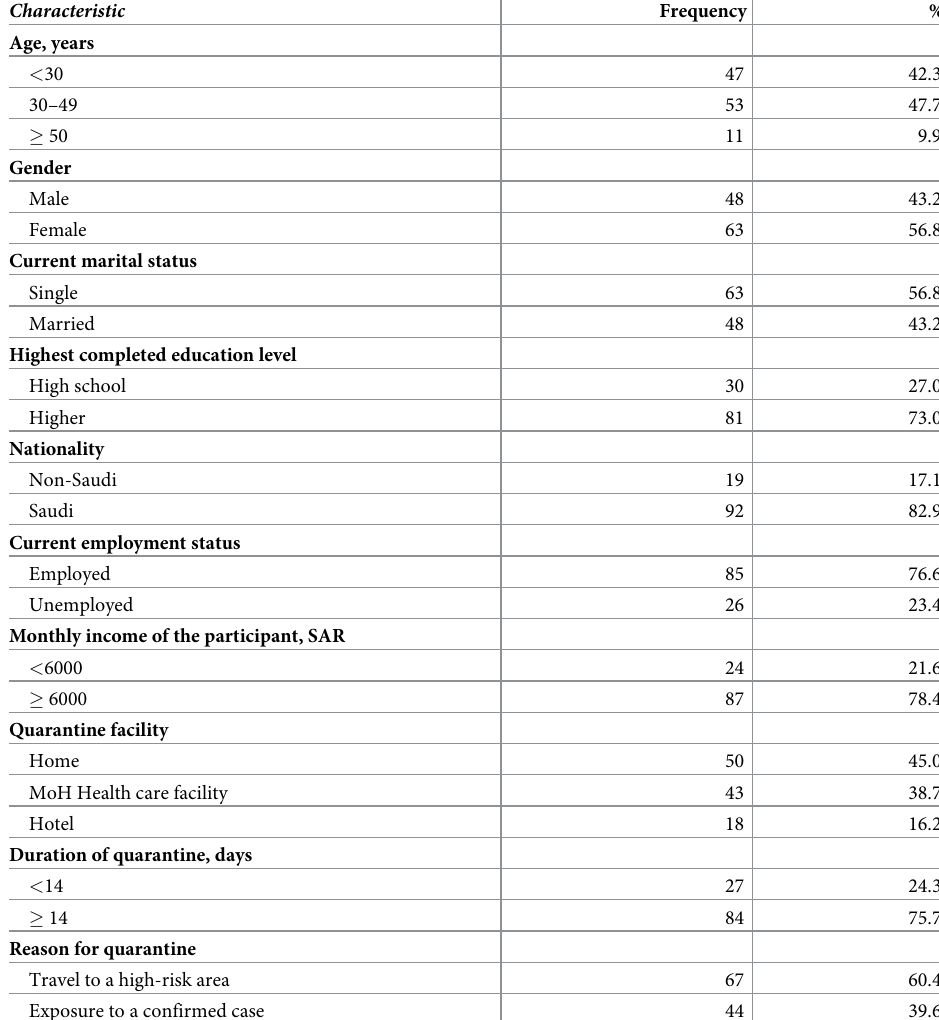
Table 1. Characteristics of survey participants (n =